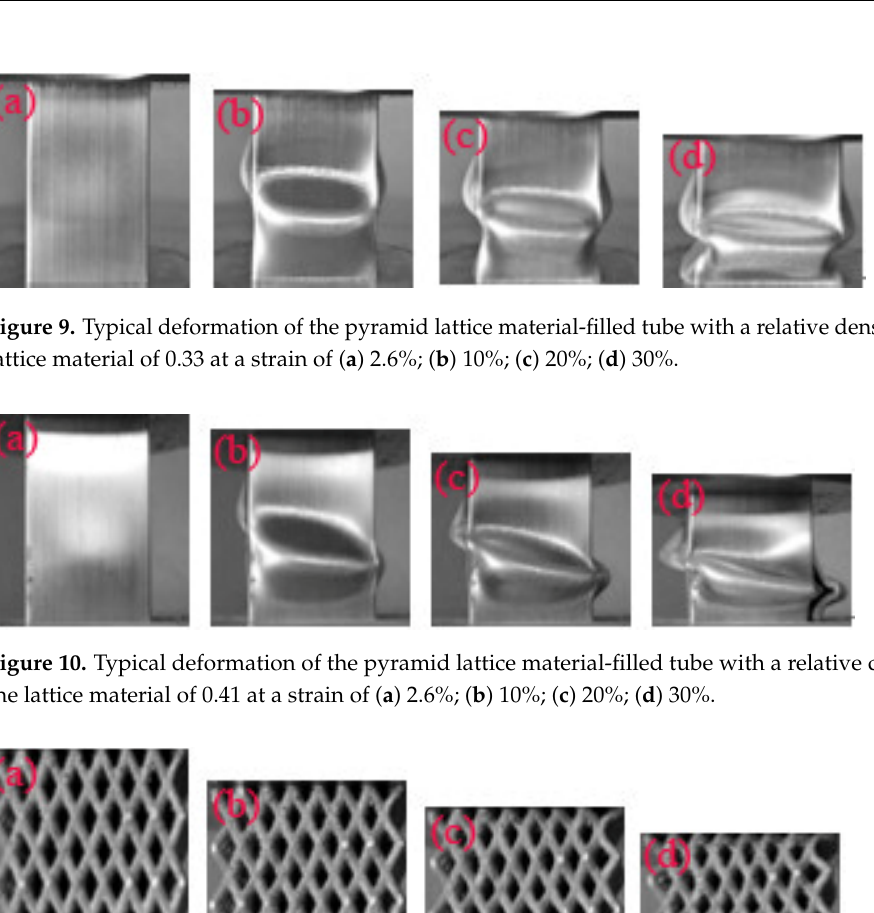
where s is the compression displacement, F ( s ) denotes the force at displacement s . The average crushing force-displacement curves of pyramidal lattice material-filled tube and empty tube are shown in Figure 12. The average crushing force-displacement curves of the pyramidal lattice material-filled tube and empty tube are similar. In the initial stage, the average crushing force increased rapidly with the increase of displacement and soon reached the peak value. After the peak value, there is a long platform area; however, after the average crushing force of empty tube reached the peak value, a significant decline occurred, caused by the rapid decrease in load due to the buckling of the pipe wall. With the increase in the relative density of the lattice material, the average crushing force of the pyramidal lattice material-filled tube